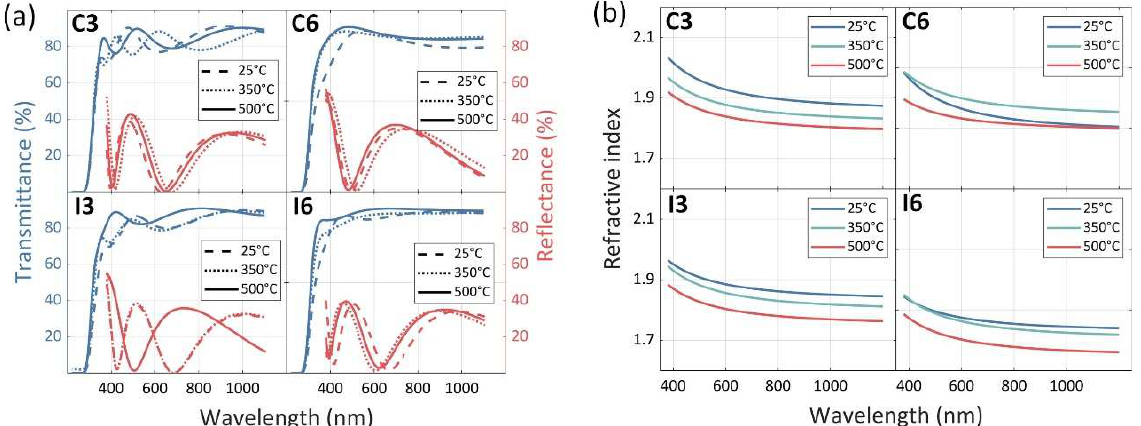
Figure 3. ( a ) Transmittance and reflectance spectra of SnO 2 thin films sputter deposited on glass and (100) Si substrates before and after an annealing treatment in air for 48 h and at 2 different temperatures (350 and 500 °C). ( b ) Evolution of the calculated refractive index vs. wavelength for all films at various temperatures.